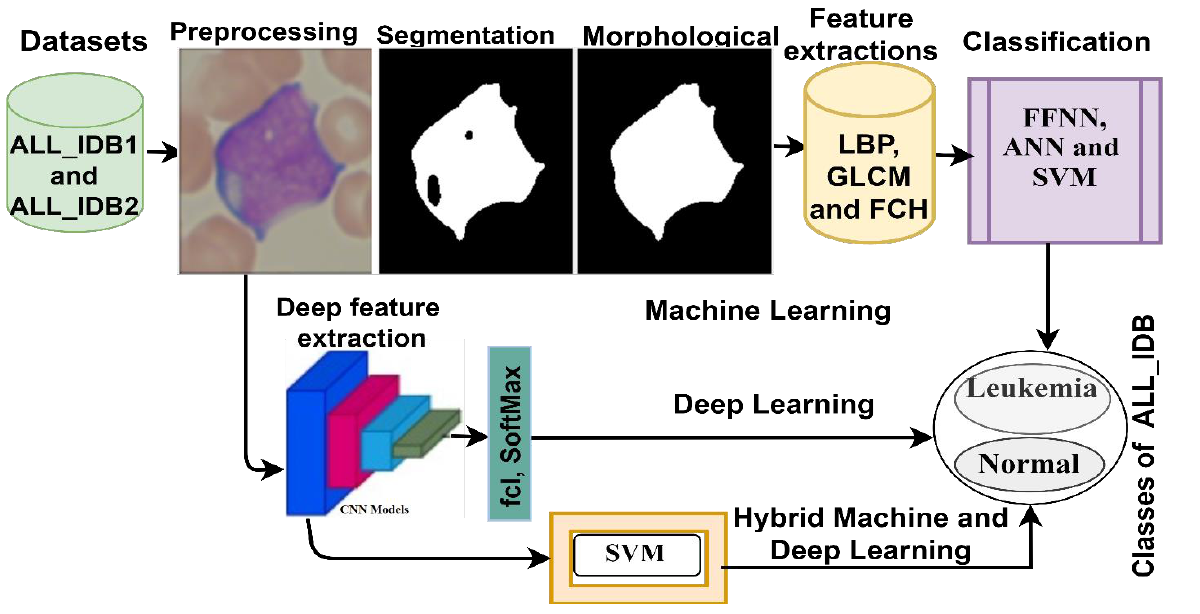
Figure 1. Morphological diagram for leukemia diagnosis from the ALL_IDB1 and ALL_IDB2 dataset.